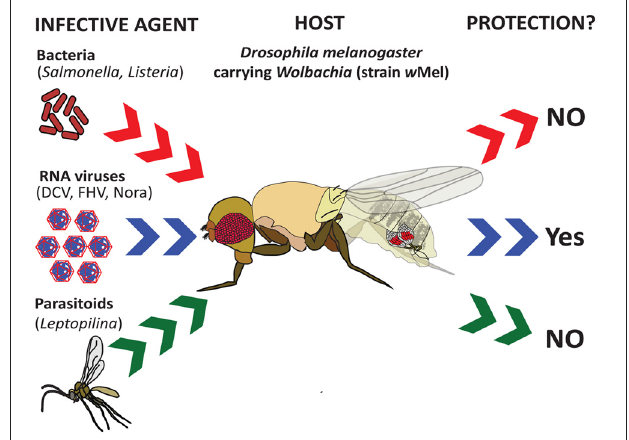
FIGURE 1 | Effect of Wolbachia endosymbiotic bacteria on the ability of Drosophila to resist infection. Recent studies have shown that the presence of Wolbachia strain w Mel in Drosophila melanogaster confers resistance to infection by various RNA viruses ( Drosophila C Virus, Flock House Virus, and Nora virus) (Teixeira et al., 2008), but not by intracellular bacterial pathogens ( Salmonella typhimurium and Listeria monocytogenes ) (Rottschaefer and Lazzaro, 2012) or parasitoid wasps ( Leptopilina boulardi ) (Martinez et al., 2012).